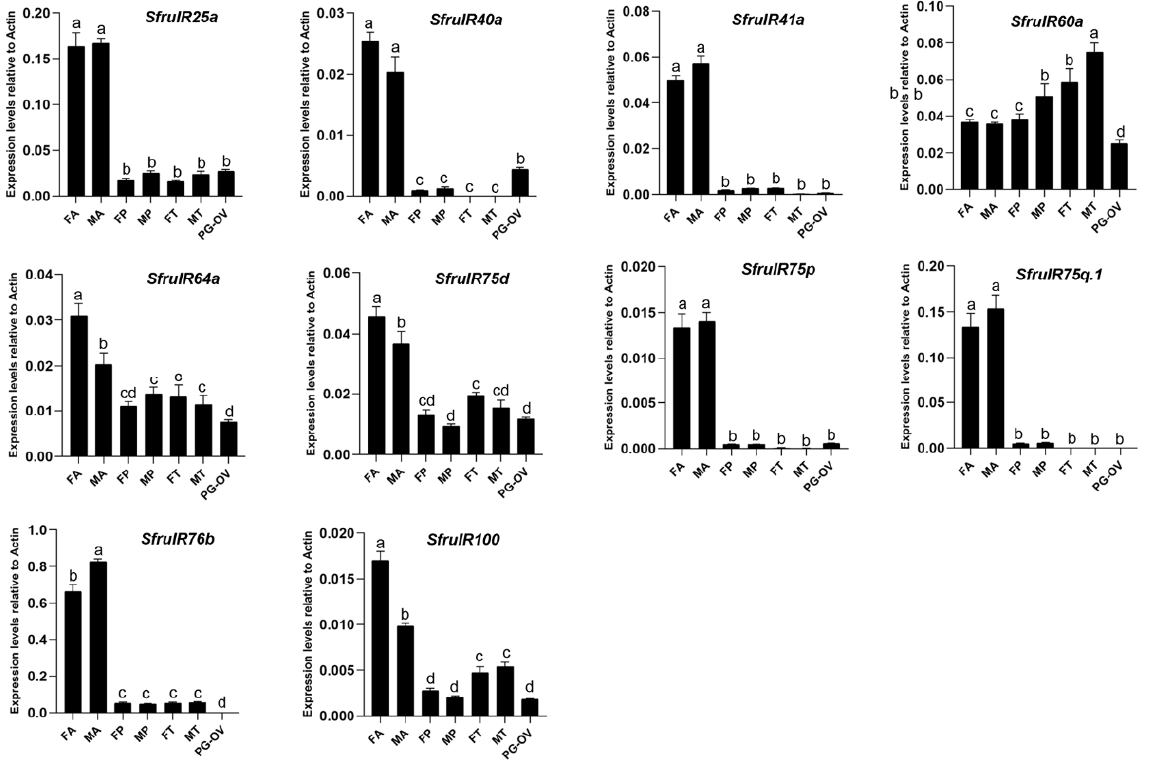
Figure 7. Expression patterns of candidate IRs in different tissues of S. frugiperda . RT-qPCR analysis of candidate IRs genes was carried out in female antennae (FA), male antennae (MA), female proboscises (FP), male proboscises (MP), female tarsi (FT), male tarsi (MT), and the female pheromone gland-ovipositor (PG-OV). Values are means + SE; in each panel, means with different letters are significantly different according to a one-way ANOVA followed by a Tukey’s multiple comparison test ( p < 0.05, n = 3).